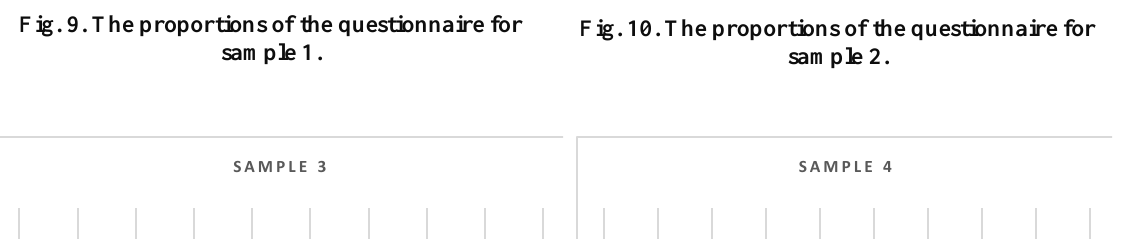
Fig. 10. The proportions of the questionnaire for sample 2.